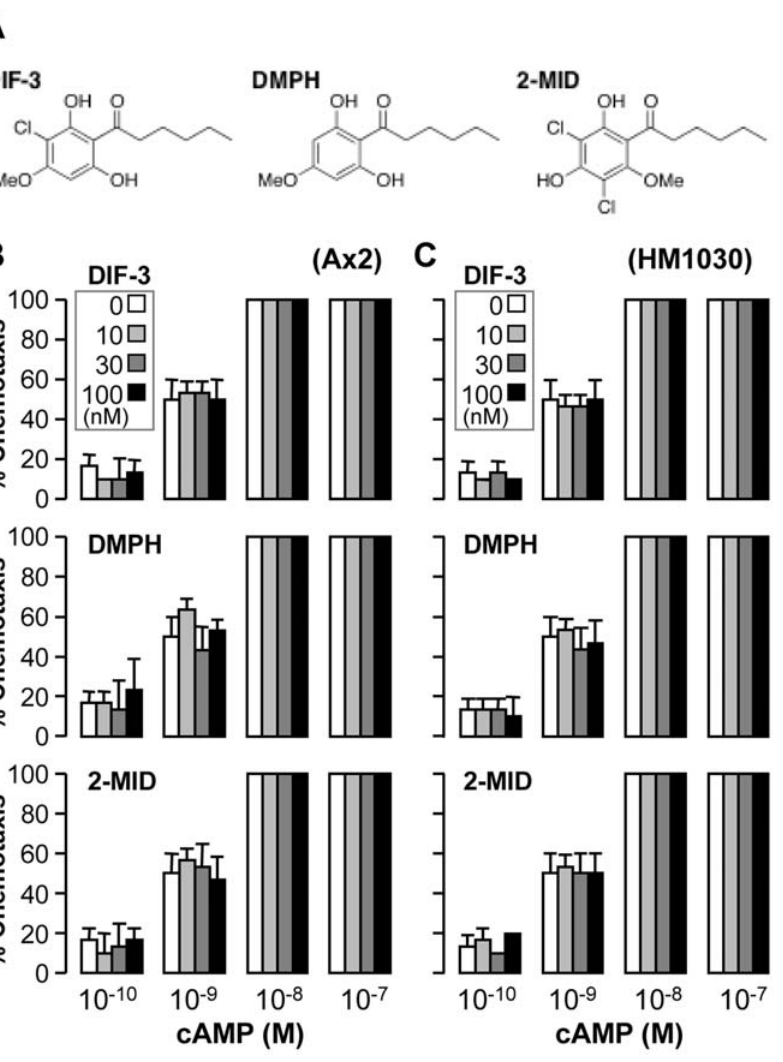
Figure 2. Effects of DIF analogs on chemotaxis in Ax2 and HM1030 cells. (A) DIF-3: 1-(3-chloro-2,6-dihydroxy-4-methoxyphenyl)hexan-1- one. 2-MIDIF-1: 2-methoxy isomer of DIF-1. DMPH: 1-(2,6-dihydroxy-4-methoxyphenyl)hexan-1-one. (B) Ax2 and HM1030 cells starved for 6 h were spotted on PB agar containing 3 mM caffeine (Control) plus the indicated concentrations of DIF-3, DMPH, or 2-MIDIF-1 (2-MID) and assayed for chemotaxis toward the indicated doses of cAMP. Data are the mean and s.d. (bars) of three independent experiments (n=3).